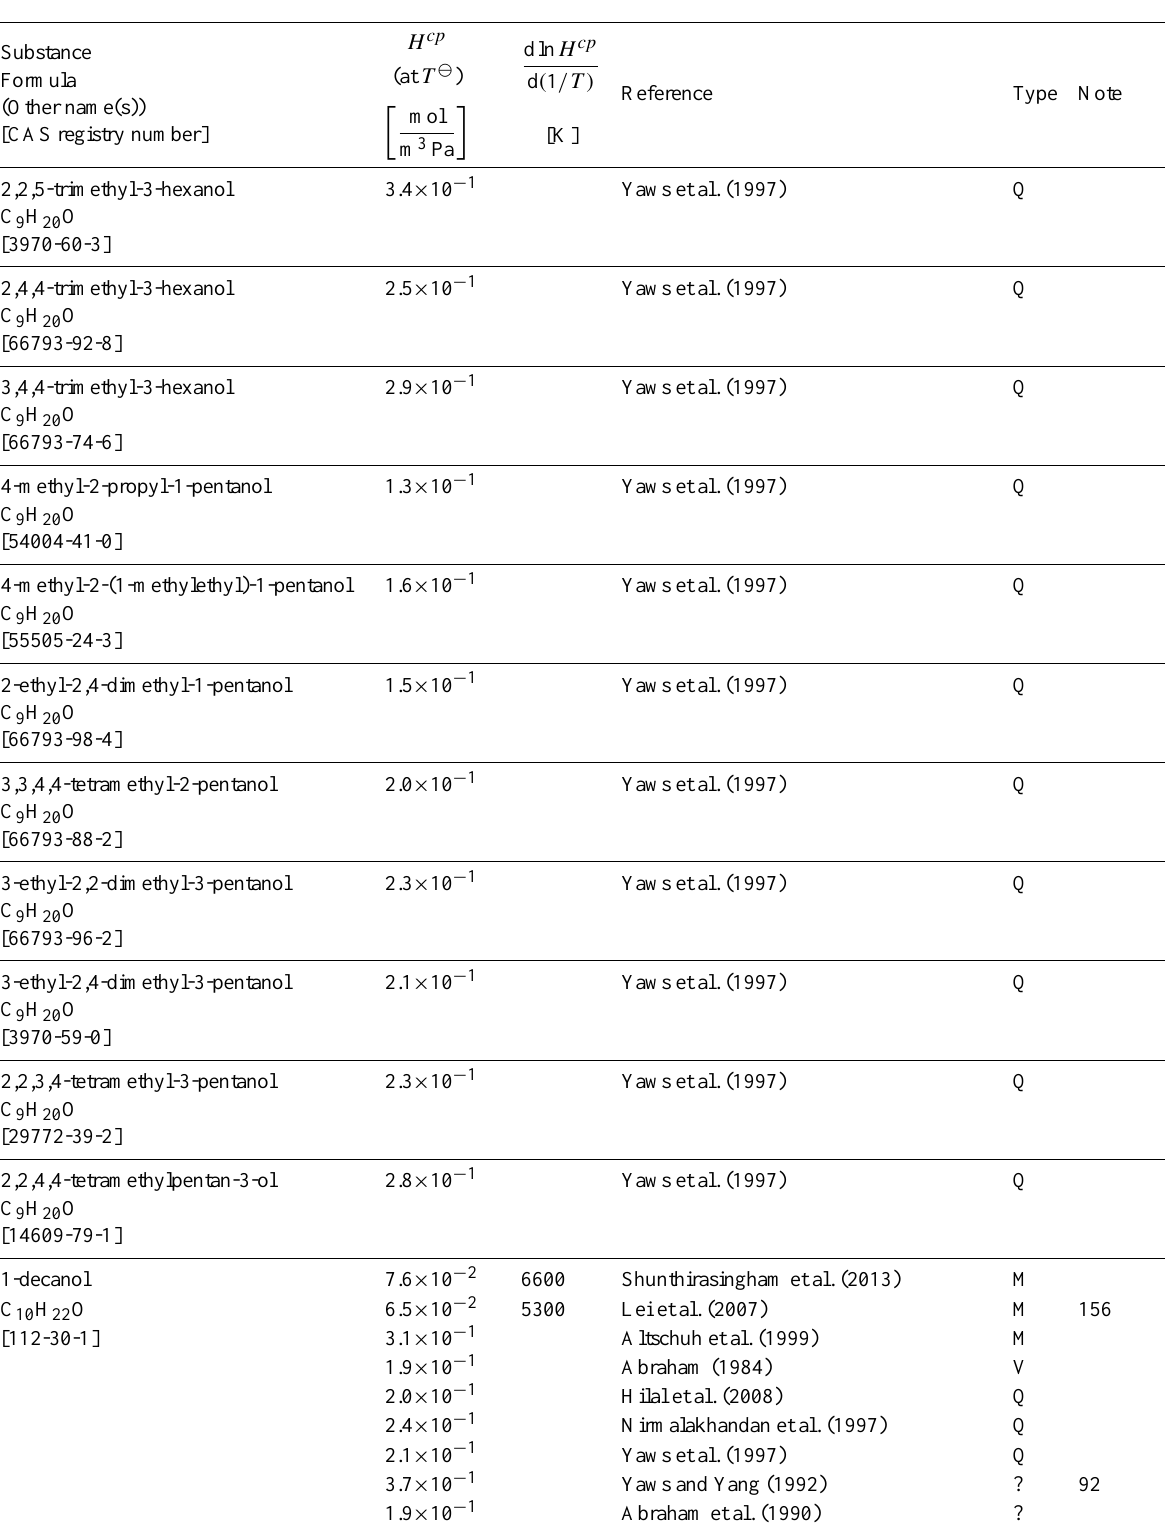
Table 6: Henry’s law constants for water as solvent